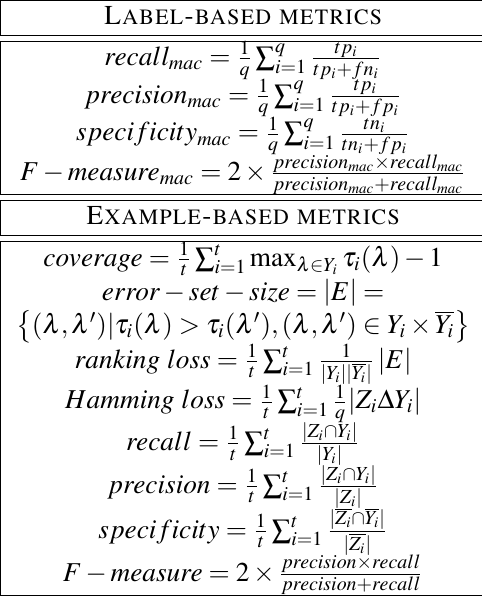
Table 8: Metrics used in